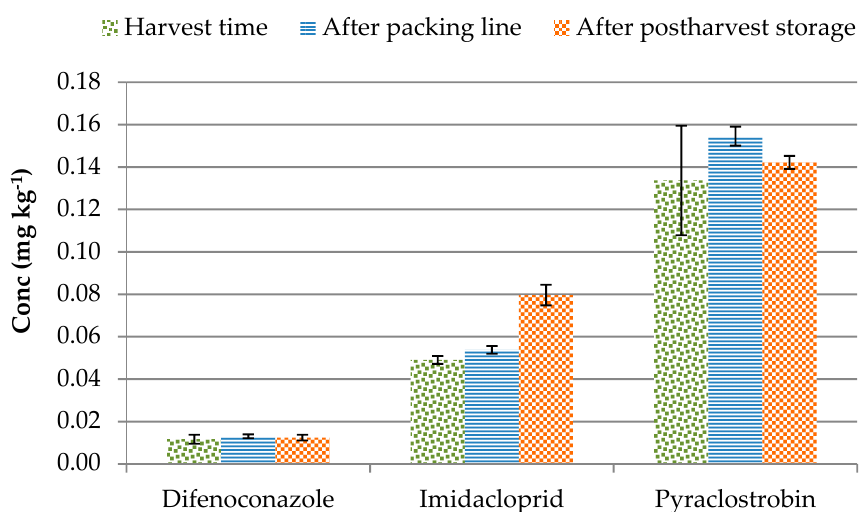
Figure 4. Difenoconazole, imidacloprid and pyraclostrobin residues on Clementine at harvest, after the postharvest packing line and after 32 d of cold storage. For difenoconazole and pyraclostrobin, no significant differences were detected between the pesticide levels. For imidacloprid residue concentration at the end of the postharvest period differed significantly from the residue level determined at harvest (Student t-test, α = 0.05).